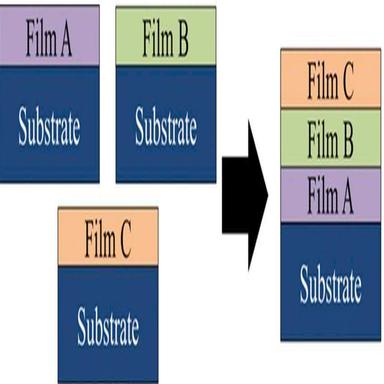
Single-layer coatings of each material are deposited on a known substrate to determine their optical functions. These optical functions can then be used as starting values when characterizing the multilayer consisting of the same coatings.